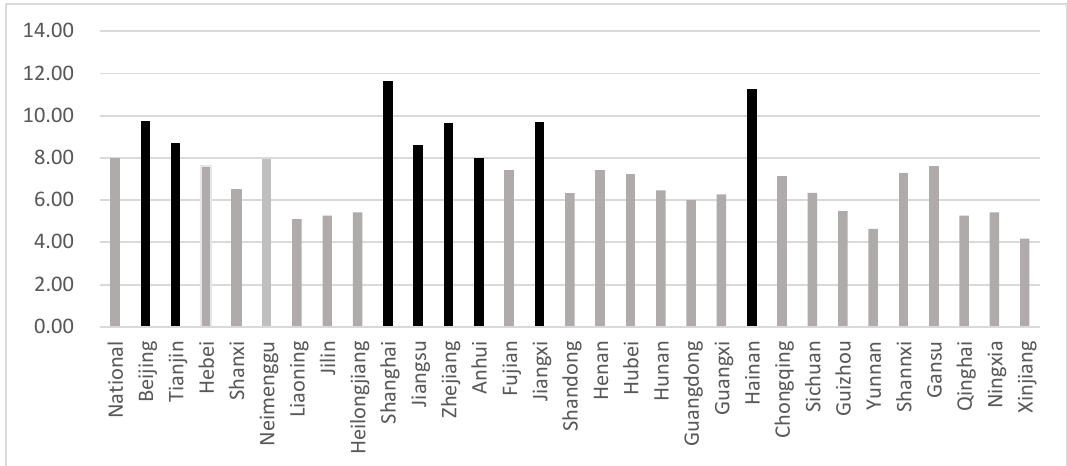
Figure 1. Average annual growth rates of regional house prices. Note: The vertical axis represents the house price growth rate (%), the horizontal axis represents the country and 30 regions. The regions that are labeled black are the regions with higher growth rates than national. All growth rates are calculated by the authors. Table 1. Average annual growth rates of house prices for 30 regions in China. Order Region Growth (%) Order Region Growth (%)